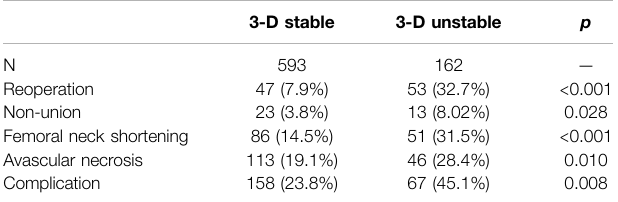
TABLE 2 | Comparison of complications between 3-D stable and unstable